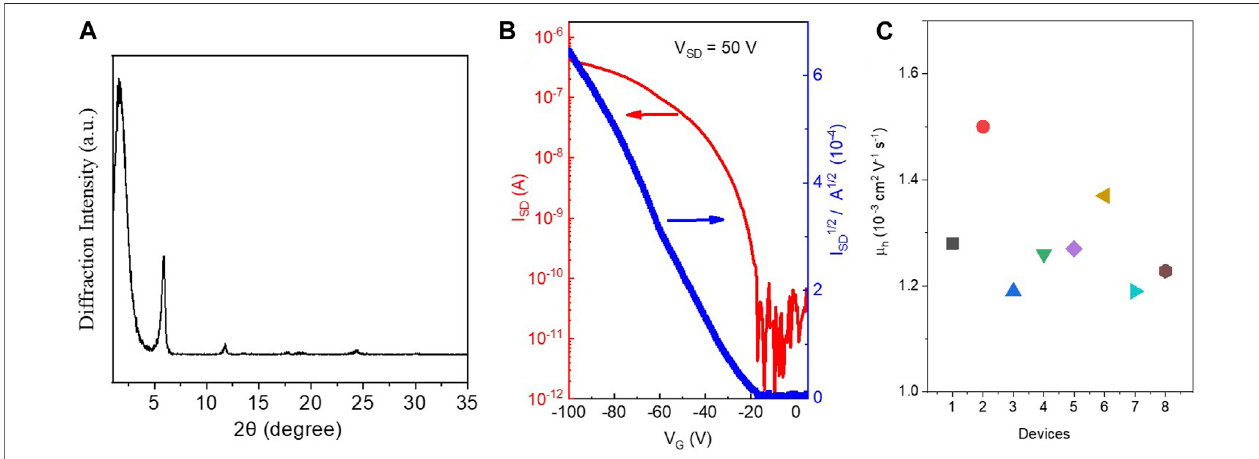
FIGURE 2 | (A) Transmission XRD diagrams of PPAB; (B) characteristics of the OFET devices of PQ1; (C) hole transport mobility obtained from eight different